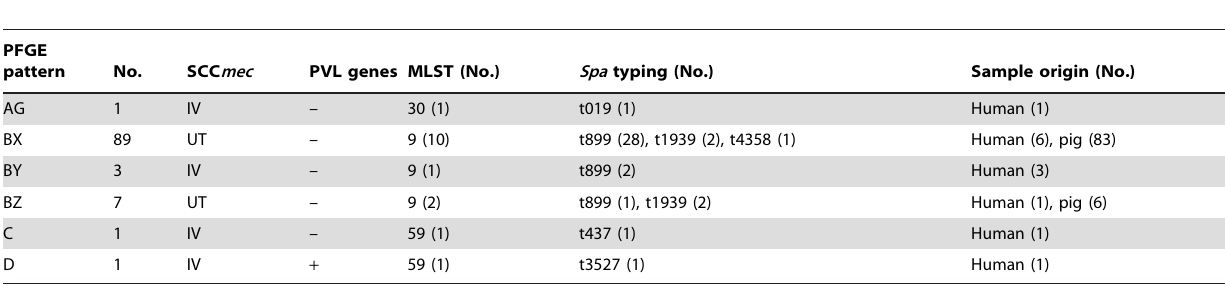
Table 4. Molecular characteristics of 102 MRSA isolates, categorized by pulsed-field gel electrophoresis (PFGE) patterns.